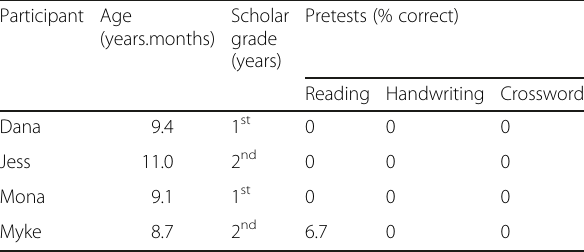
Table 1 Participants ’ ages and scores in the reading, handwriting, and crossword